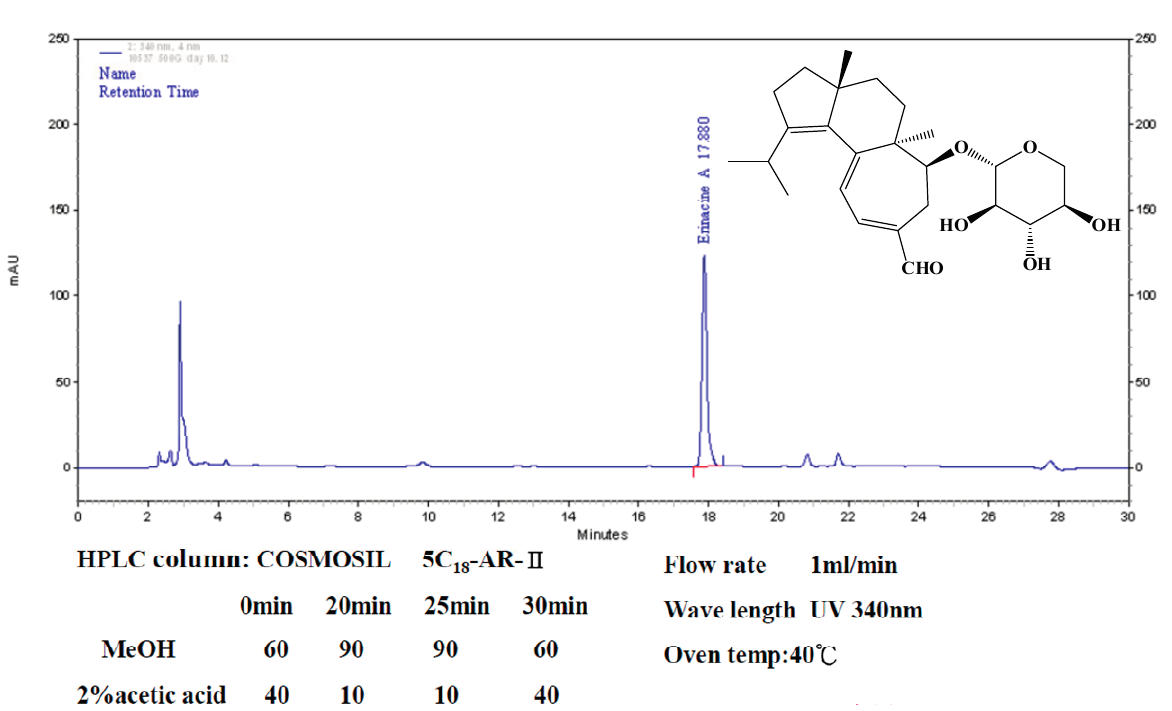
sample ( right ) and the ethanol extract of H. erinaceus mycelium ( bottom ) from 20-ton bioreactor (UV detection at 340 nm). Retention time of erinacine A is 17.4